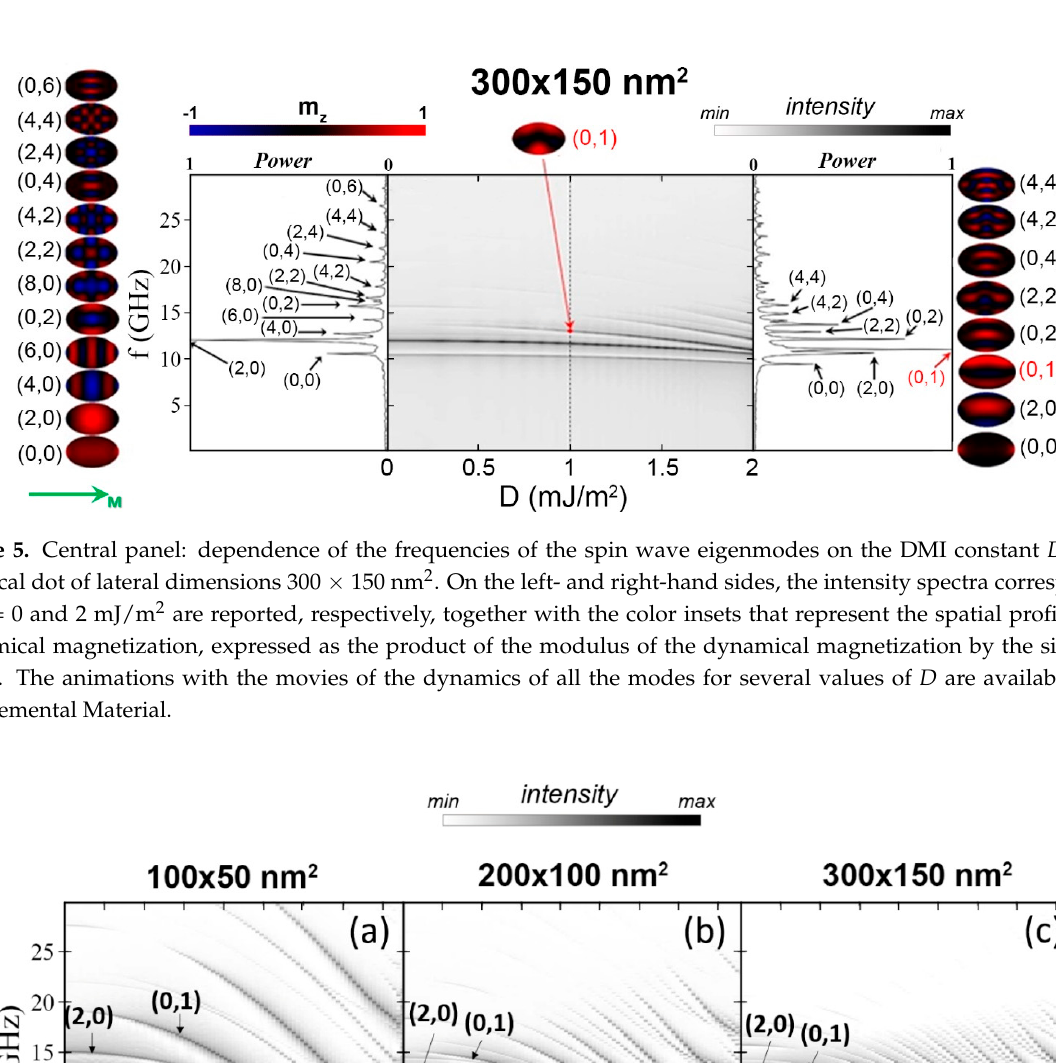
Figure 5. Central panel: dependence of the frequencies of the spin wave eigenmodes on the DMI constant D for the elliptical dot of lateral dimensions 300 × 150 nm 2 . On the left- and right-hand sides, the intensity spectra corresponding to D = 0 and 2 mJ/m 2 are reported, respectively, together with the color insets that represent the spatial profile of the dynamical magnetization, expressed as the product of the modulus of the dynamical magnetization by the sign of its phase. The animations with the movies of the dynamics of all the modes for several values of D are available in the supplemental material.